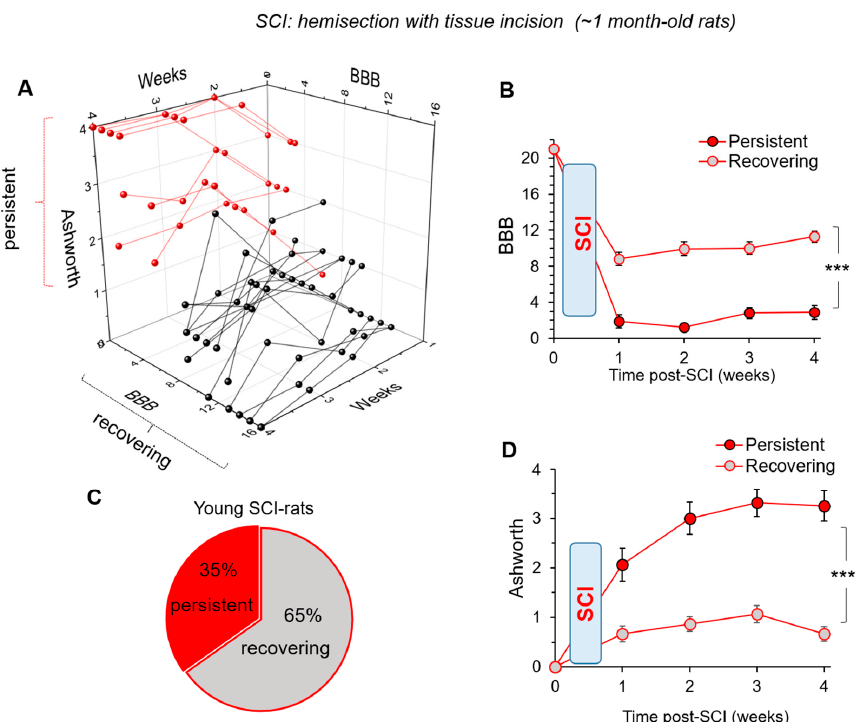
Figure 3. Young SCI rats reveal the following two groups of animals: those with persistent or recovering motor deficits. ( A ) The distribution profiles of changes in the motor function on the ipsilateral to injury side, showing individual BBB scores plotted against the corresponding Ashworth scoring for weeks 1 to 4 after injury. Pooled group of SCI rats, n = 23, consisted of 8 SCI rats with persistent and 15 SCI rats with recovering motor deficit. ( B ) The time course of motor deficit on the ipsilateral to injury side assessed with the BBB score for ‘persistent’ and ‘recovering’ groups of SCI rats. ( C ) The distribution of ‘persistent’ and ‘recovering’ groups of SCI rats based on the time course of motor deficit. ( D ) Same as in ( B ) but for muscle tone assessed with the Ashworth score. Data are mean ± SEM. *** p < 0.001 (ANOVA with Tukey post-hoc